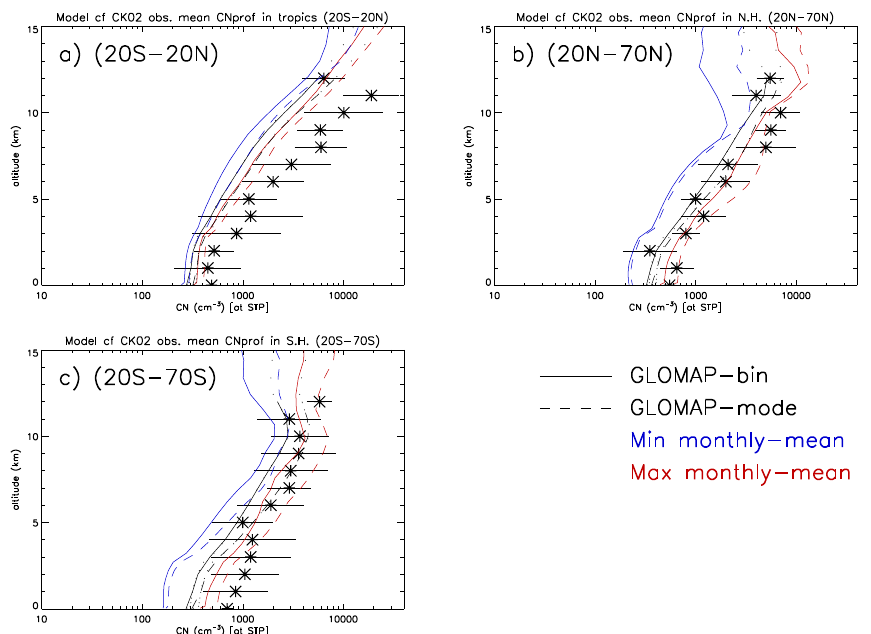
Fig. 14. Simulated ultrafine CN ( D p > 3nm) profiles (lines) over the Pacific and Southern Oceans compared to aircraft observations (aster- isks) from Clarke and Kapustin (2002) in the latitude ranges (a) 20 ◦ S–20 ◦ N, (b) 20 ◦ N–70 ◦ N and (c) 20 ◦ S–70 ◦ S. Model CN concentrations are at standard temperature and pressure and means over the longitude ranges (a) 135–180 ◦ E, (b) 175–270 ◦ E and (c) 200–240 ◦ E respec- tively, following the approach in Spracklen et al. (2005). Values of b and R are calculated for each region (see Table 5) from model values interpolated to a 1km grid to match the observations. The error-bars around the asterisks show the observed standard-deviation in each 1km altitude range. The black line shows simulated annual mean profile and the blue/red lines show minimum/maximum monthly-mean values for GLOMAP-bin (solid) and GLOMAP-mode v6R